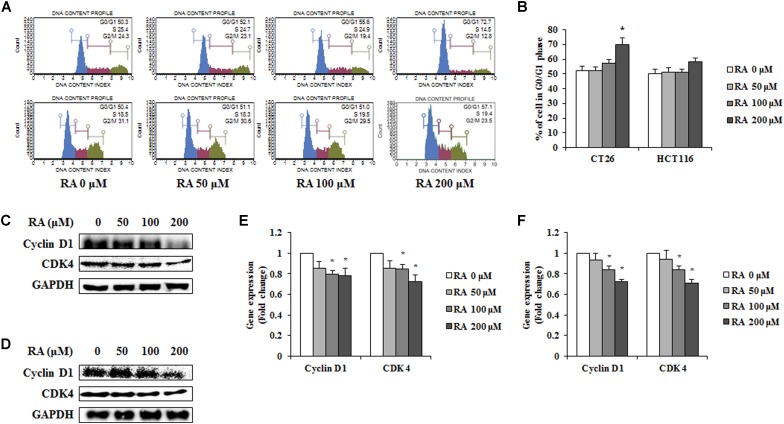
Rosmarinic acid (RA) induces G0/G1 phase arrest in CRC cells. (A) The cell cycle analysis of RA-treated CT26 cells for 48 h (upper part) and RA-treated HCT116 cells for 24 h (lower part) (B) The population of cells in each cell cycle phase in RA-treated CT26 and HCT116 cells. (C,D) The proteins expression of cyclin D1 and CDK4 in RA-treated CT26 cells for 48 h (C) and RA-treated HCT116 cells for 24 h (D). (E,F) The mRNA expression of cyclin D1 and CDK4 in RA-treated CT26 cells for 48 h (E) and RA-treated HCT116 cells (F) for 24 h. GAPDH and β-actin were used as the endogenous control. The results are expressed as the mean ± SD. ∗p < 0.05 indicates a significant difference from the untreated group.